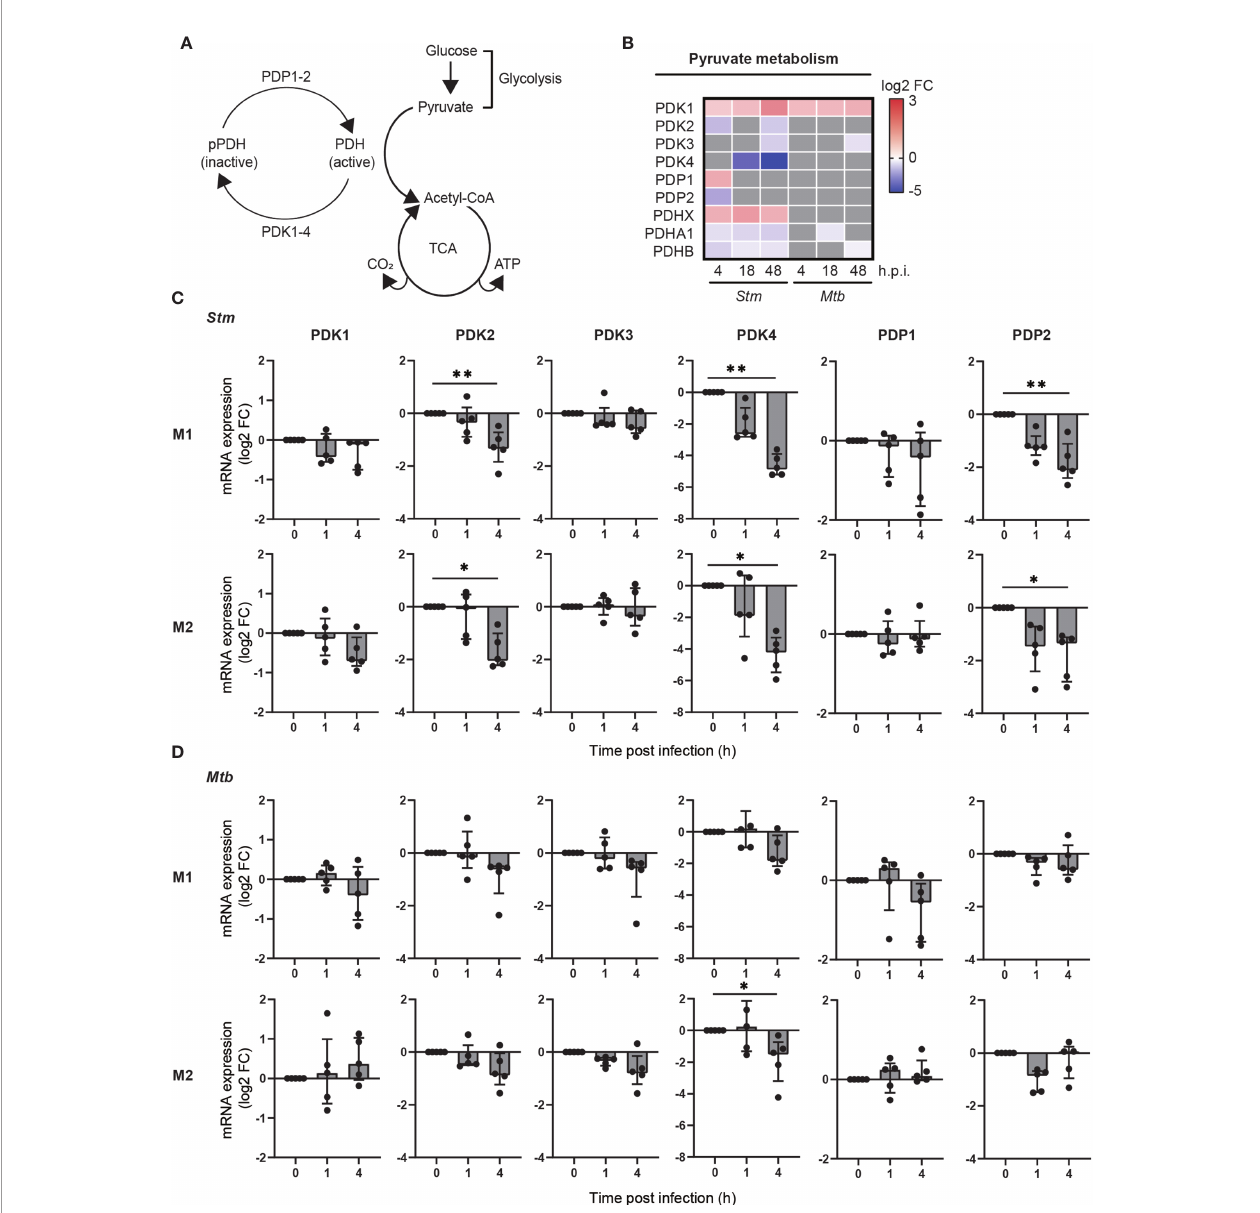
FIGURE 3 | Pyruvate metabolism was regulated during Stm infection at the transcriptional level in human macrophages. (A) Schematic representation of the PDC, linking glucose metabolism with the TCA cycle and respiratory electron transport. (B) Differential expression analysis by limma-voom of genes involved in pyruvate metabolism over time in Stm - or Mtb -infected relative to uninfected M2 macrophages. Signi fi cantly up- (red) or downregulated genes (blue) (adjusted p-value < 0.05) are indicated on a log 2 -FC scale. Grey indicates non-signi fi cantly differentially expressed genes. Data obtained from Blischak et al. (45) (C, D) mRNA expression levels were quanti fi ed in Stm - or Mtb -infected M1 (top panels) and M2 (bottom panels) prior to infection (0) or 1 or 4 hours post infection using GAPDH as the housekeeping control gene. Data represent the median ± interquartile range of fi ve donors. Differences were signi fi cant by RM one-way ANOVA with Dunnett ’ s multiple test correction against the corresponding uninfected control. *p < 0.05, **p <